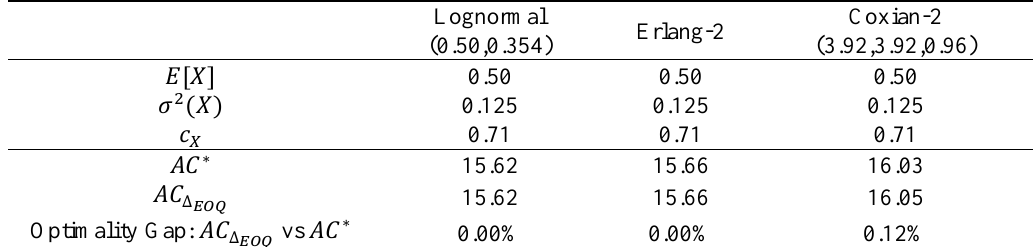
Table 3. The impact of processing time distributions with same 𝐸[𝑋] , 𝜎 2 (𝑋) and 𝑐 𝑋